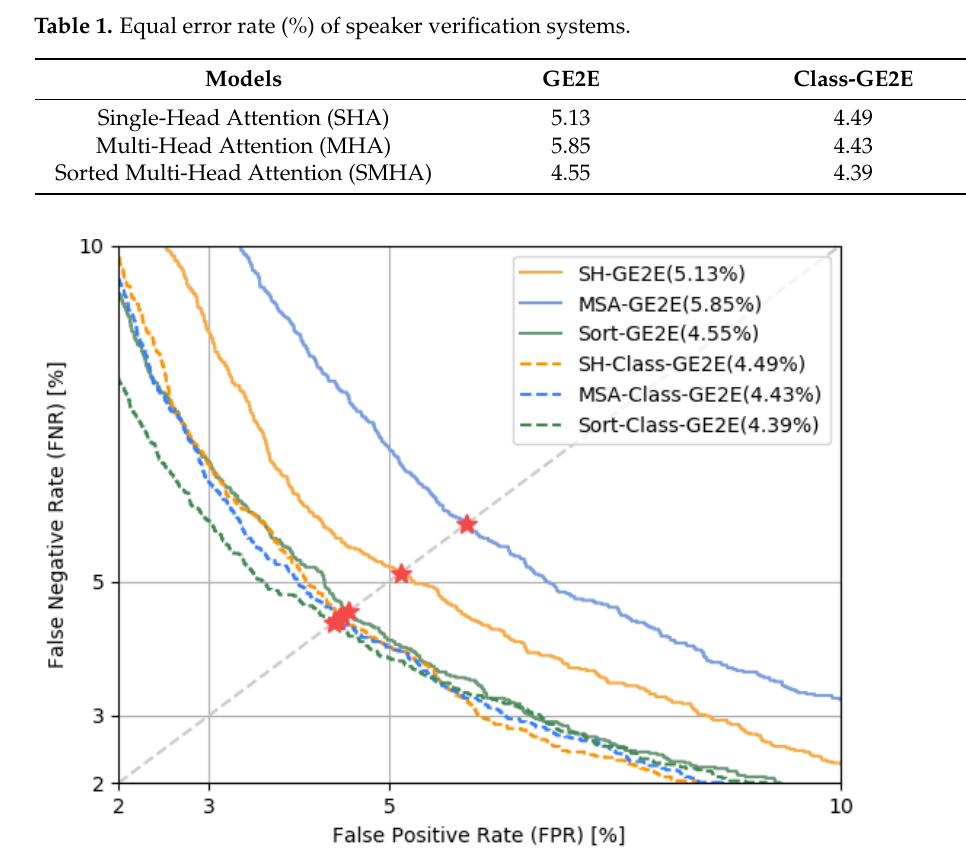
Figure 3. Detection error tradeoff curve of models using multiple attention techniques.